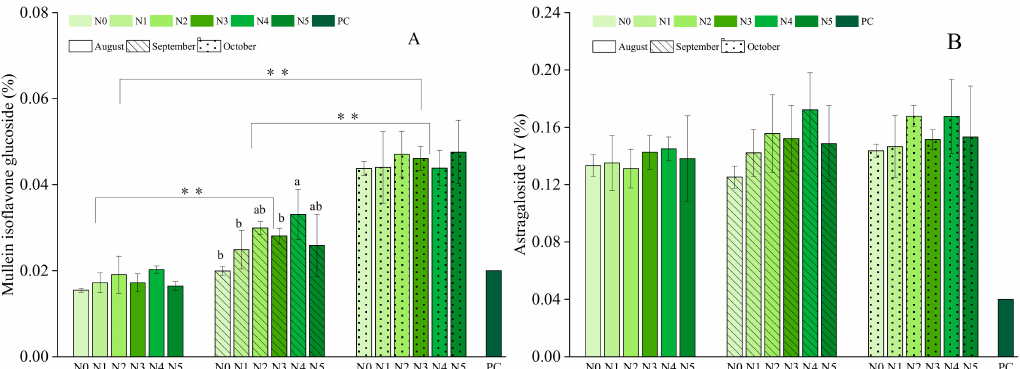
Figure 3. Mullein isoflavone glucoside (%) and Astragaloside IV (%) at di ff erent harvest stages from August to October (( A ) Mullein isoflavone glucoside from August to October; ( B ) Astragaloside IV from August to October) under di ff erent nitrogen treatment levels: N0 = 0 kg / ha (unfertilized control), N1 = 37.5 kg / ha, N2 = 75 kg / ha, N3 = 112.5 kg / ha, N4 = 150 kg / ha, N5 = 187.5 kg / ha, PC = Pharmacopoeia criterion (0.02%, 0.04%). Data represent means ± standard errors (SE). Significant di ff erences at p <